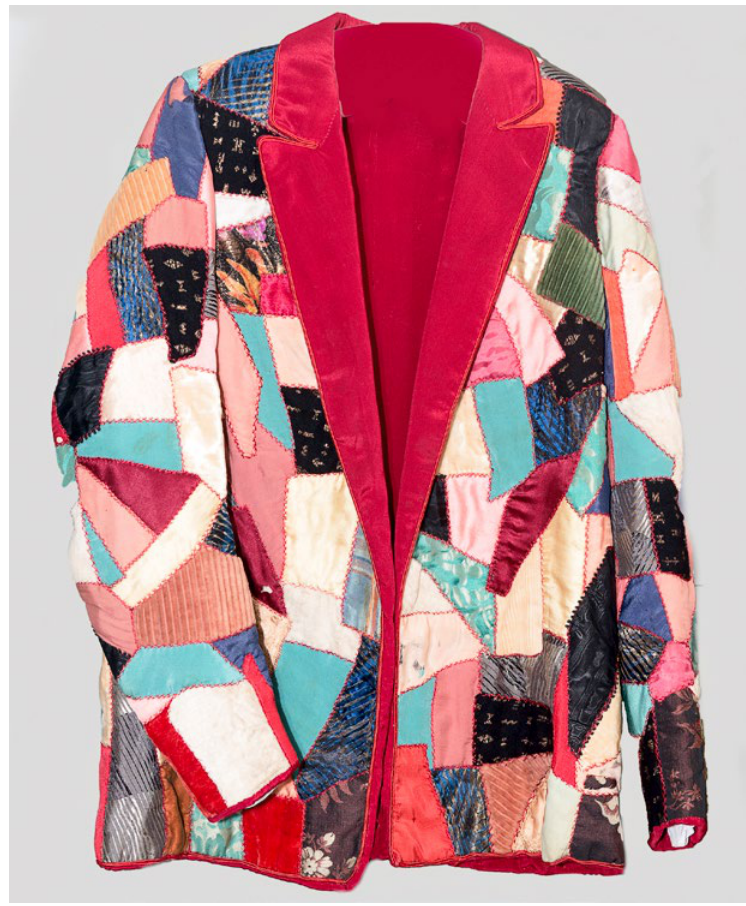
Figure 8.2 ‘Valentine’s patchwork coat of many colours’. Photograph: George Wickham. Courtesy of the Dorset County